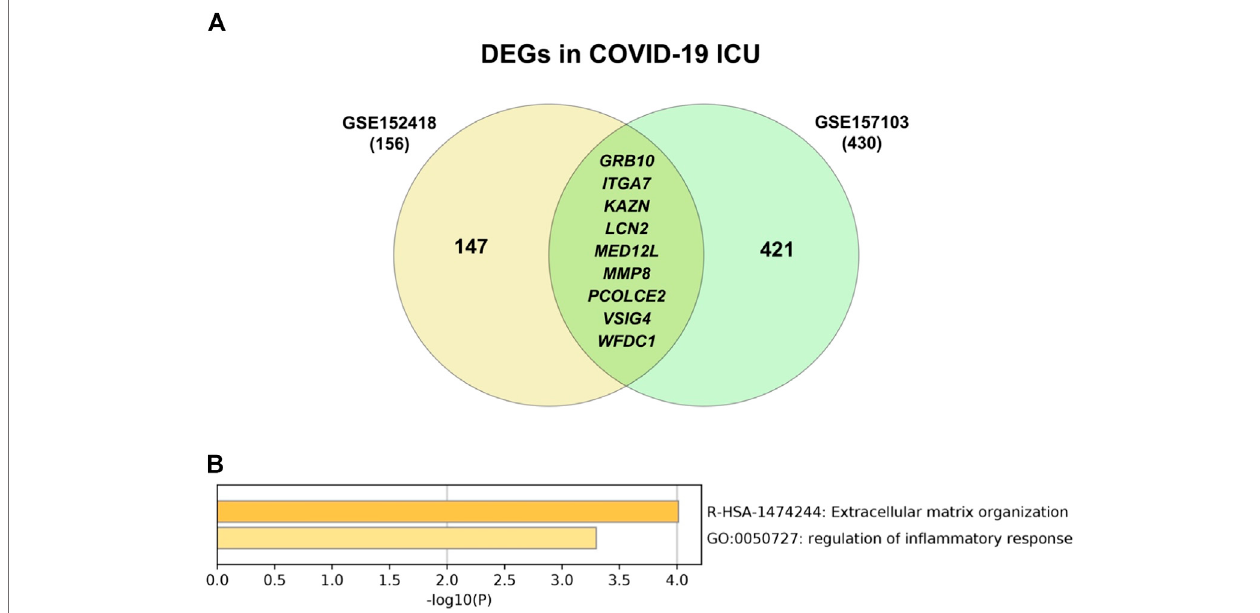
FIGURE 15 | (A) Intersecting differentially expressed genes in ICU patients from two different studies (GSE152418 & GSE157103) showed that there are nine genes commonly differentiated in ICU patients (B) and these genes are involved in ECM organization and immune response regulation when upon enrichment.